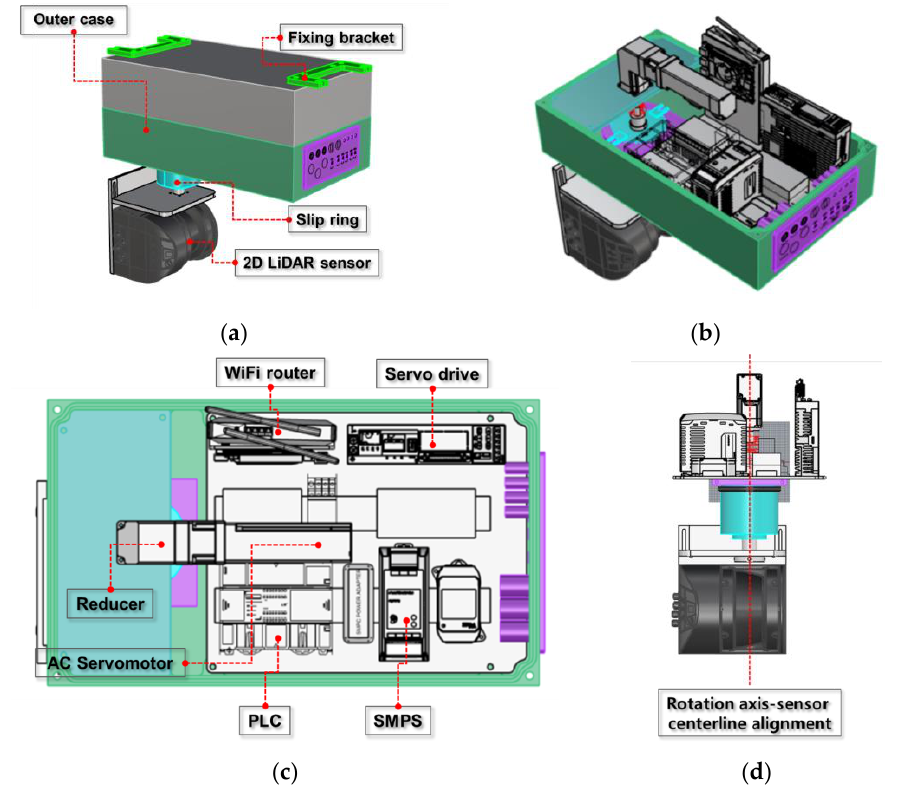
Figure 5. Design of the retaining wall displacement measurement hardware. ( a ) Perspective view; ( b ) perspective view inside the hardware; ( c ) layout of components inside the hardware; ( d ) alignment between the rotation axis of the reducer and centerline of the 2D LiDAR sensor.